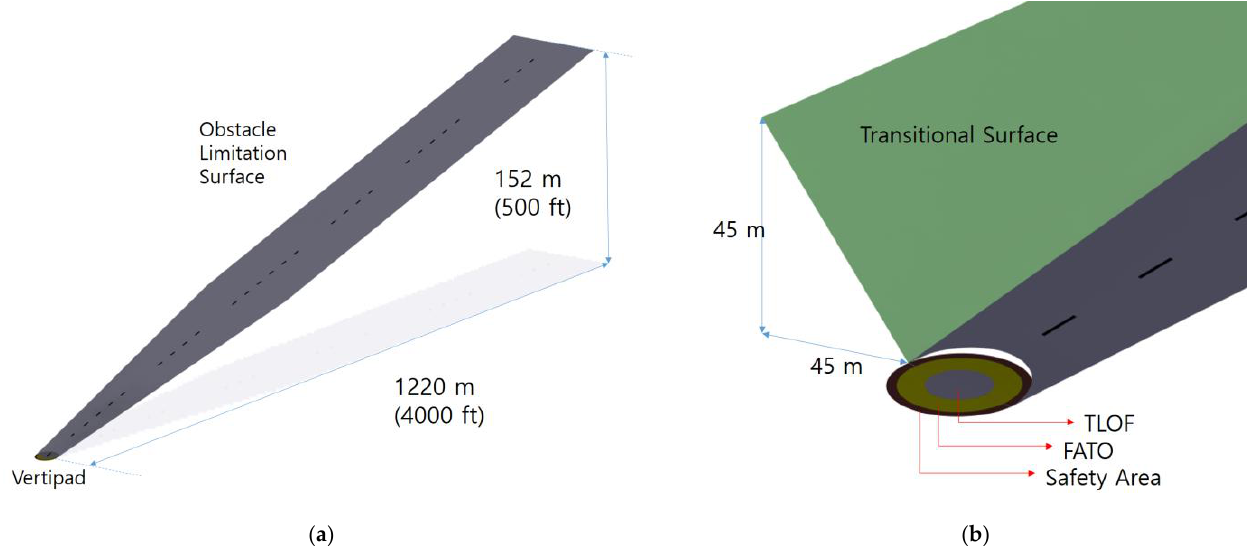
Figure 7. Approach/departure surface and transitional surface with a 1:8 slope: ( a ) approach/departure surface; ( b ) transitional surface.